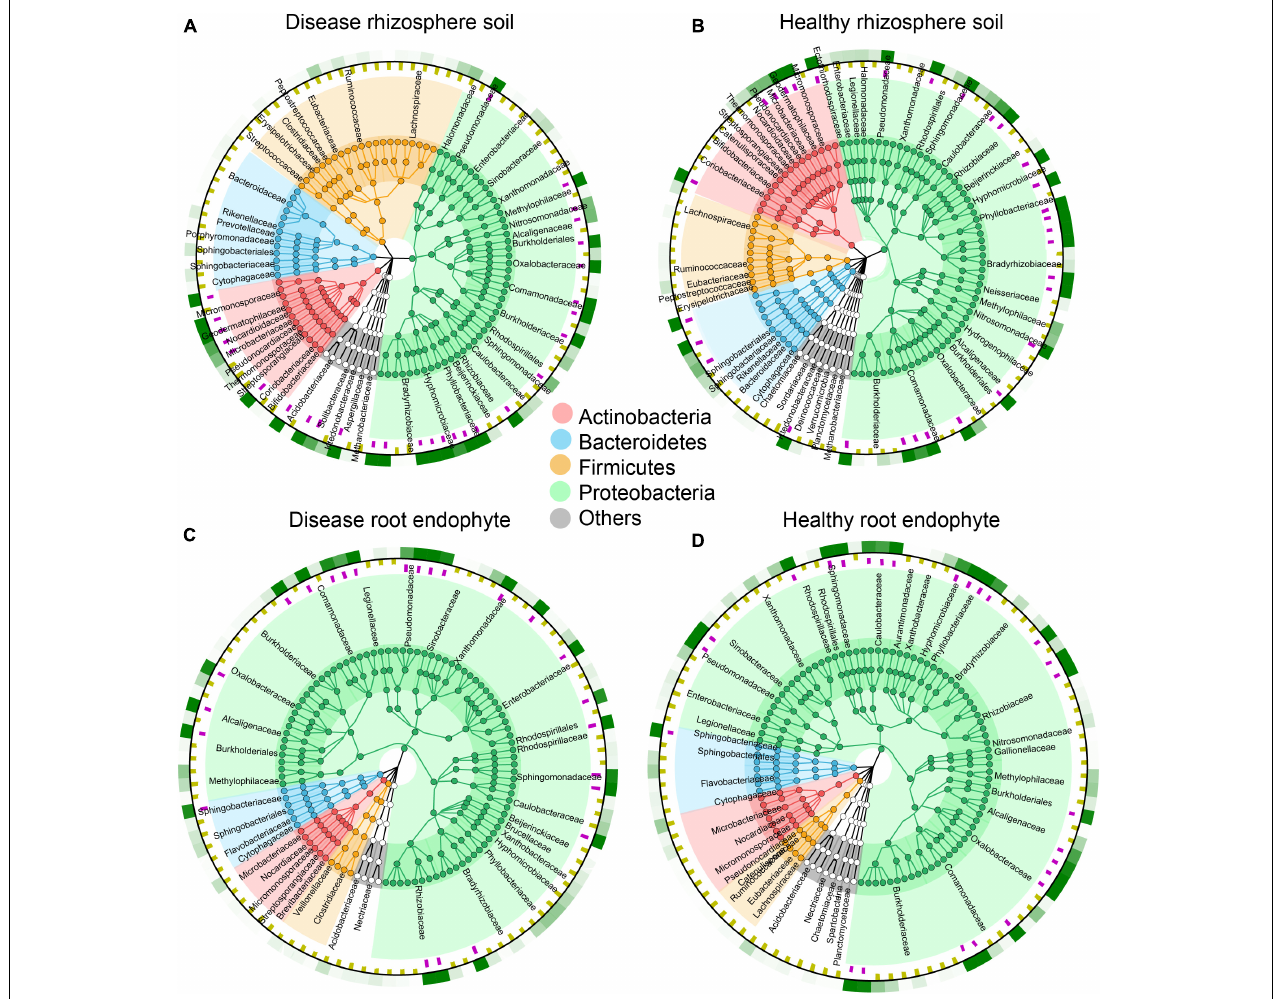
FIGURE 2 | Species composition circle diagrams based on the top 100 most abundant species in rhizosphere soil and root endophyte samples. The colors represent the four phyla that contain these species. The purple squares in the first ring indicate the species with an abundance greater than 5 per 1,000. The yellow squares in the second ring indicate the species with an abundance less than 5 per 1,000. The third ring indicates the average value for all samples, where the different shades of green show the different species abundances. (A) Top 100 most abundant species in disease rhizosphere soil. (B) Top 100 most abundant species in healthy rhizosphere soil. (C) Top 100 most abundant species in disease root endophyte. (D) Top 100 most abundant species in healthy root